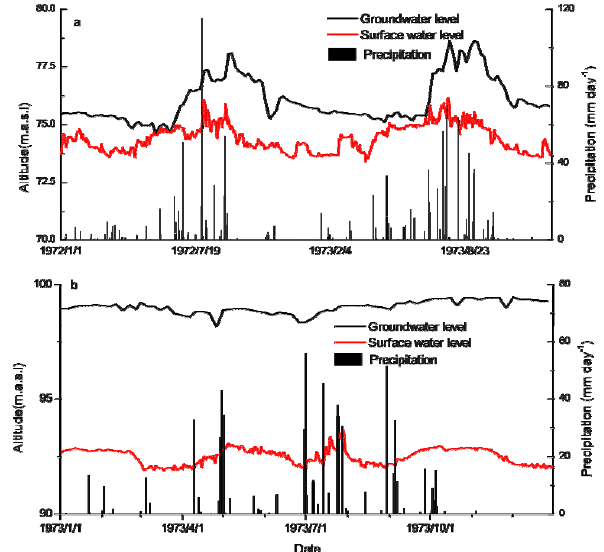
Fig. 5 Fig. 5. Comparison of groundwater level with surface water level at Zhongmou (a) and Xinzheng (b) . Daily precipitation is plotted in the right y-axis. Locations are in shown in Fig.